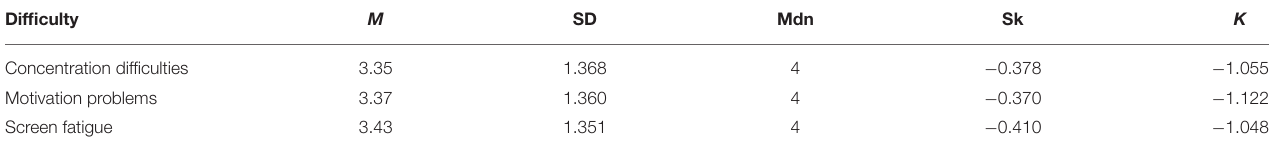
TABLE 3 | Descriptive statistics of ratings of difficulties of using screens and web